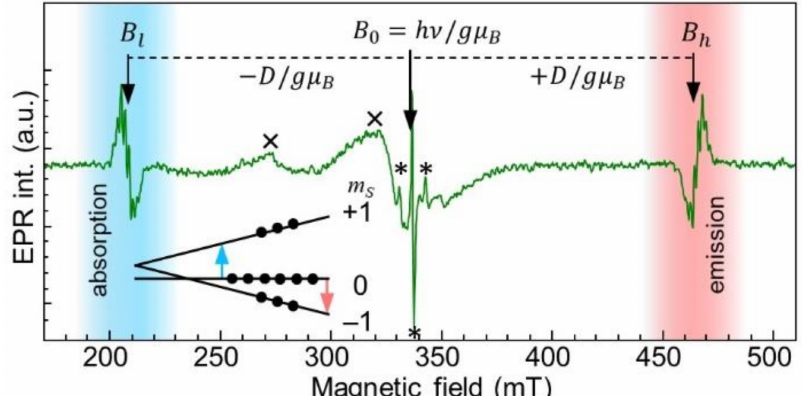
Figure 3. X-band ESR spectrum registered in the electron-irradiated hBN sample at T = 35 K under λ = 532 nm excitation at B || c , azimuthal angle θ = 0 ◦ . Triplet fine-structure lines together with the magnetic field corresponding to the center of gravity are labelled as B l , B h , and B 0 , respectively. Blue- and red-shaded areas indicate absorption and emission of the MW power, respectively. Inset shows S = 1. Zeeman levels diagram on which optically induced predominant population of the m s = 0 in the triplet ground state is shown. Allowed magnetic dipole transitions are indicated by arrows. With symbol × , artifacts arising from the resonator are marked. EPR signals corresponding to the unidentified paramagnetic centers in hBN are labeled with